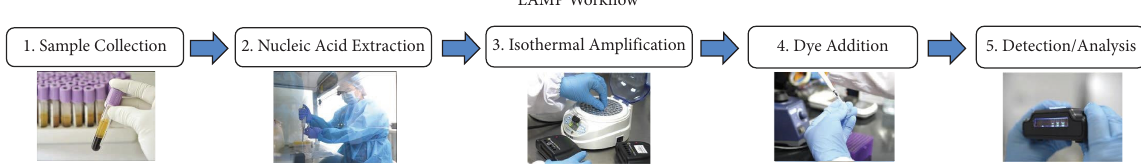
Figure 1: Typical loop-mediated isothermal amplifcation (LAMP) workfow in clinical diagnosis setting. (1) A clinical sample (e.g., blood, serum, stool, nasal swab) from the patient is frst collected and then subjected to (2) nucleic acid extraction, where the DNA or RNA from the sample is isolated, purifed, and concentrated. (3) Te extracted nucleic acid is then added to the LAMP reaction mixture and incubated isothermally for 60 minutes. (4) After amplifcation, the reaction tube is opened, and an intercalating dye (SYBR green dye) is put into the mixture. (5) Analysis can be done using the naked eye or by viewing through a blue LED light. Using the naked eye, positives appear yellow- green, and negatives appear orange. Trough a blue LED light, positives appear as bright fuorescent yellow green, and negatives appear as dull and colorless. Agarose gel electrophoresis can also be performed to confrm the amplifcation of target products. Ladder-like bands are characteristic of LAMP